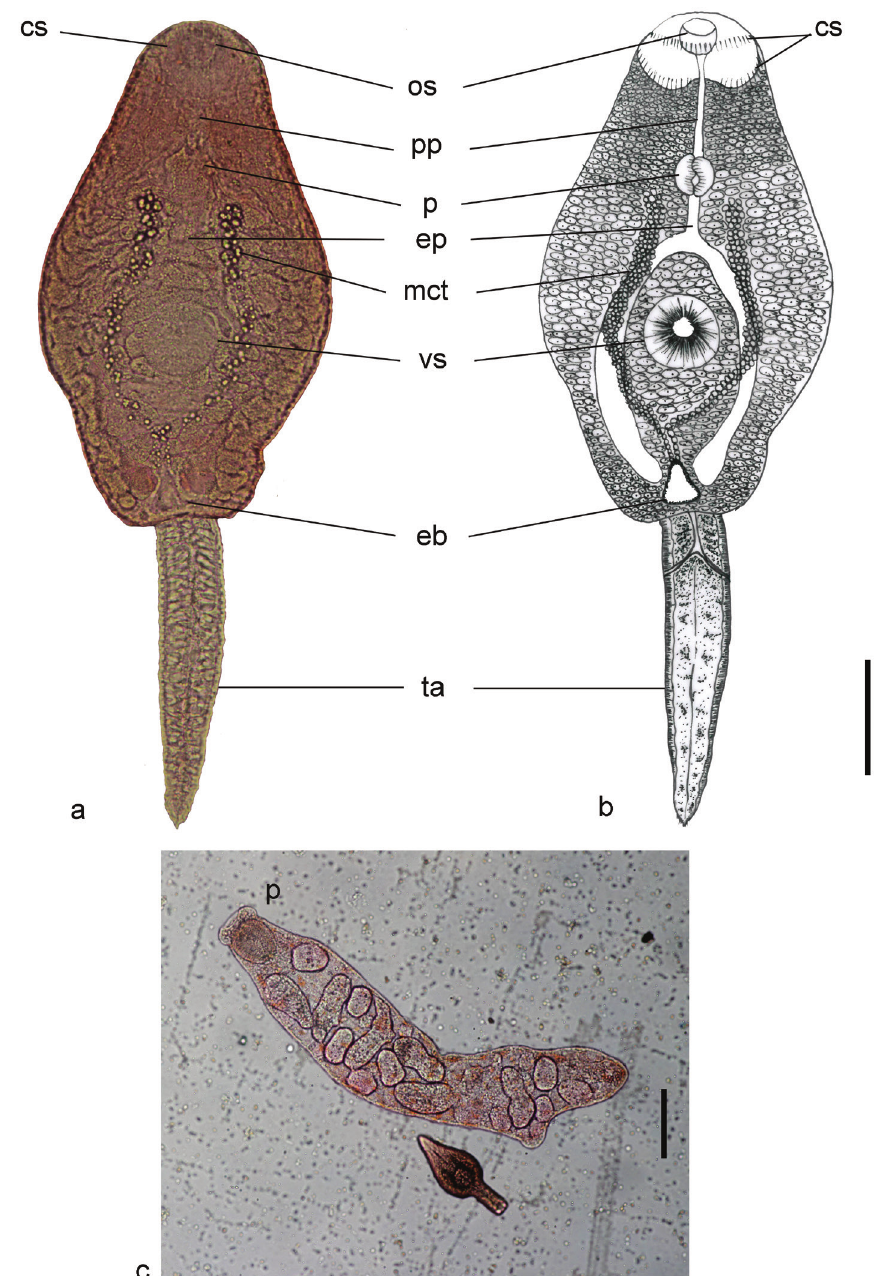
Figure 16. Echinostome cercaria. a . specimen stained with 0.5% neutral red. b . drawing of cercaria. c . redia stained with 0.5% neutral red. Abbreviations – cs: collar spines; eb: excretory bladder; ep: esophagus; mct: main collecting tube; os: oral sucker; p: pharynx; pp: prepharynx; ta: tail; vs: ventral sucker. Scale bars: 50